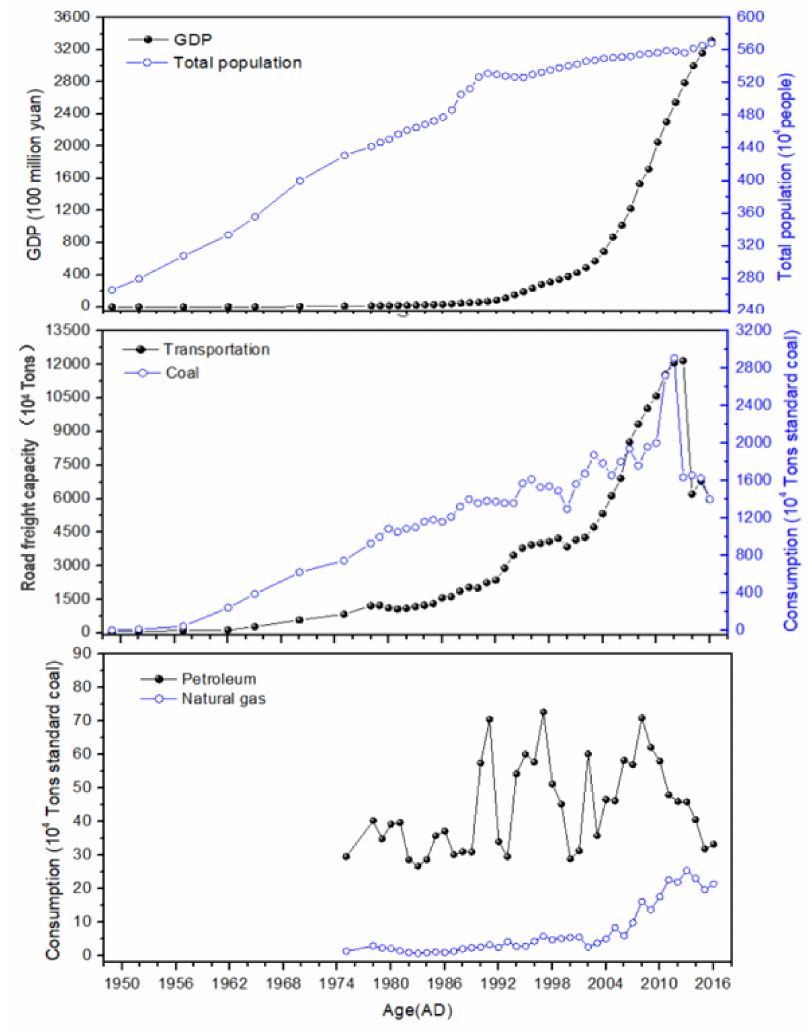
Figure 5. Statistical data on the socioeconomic development and energy consumption in Tai’an